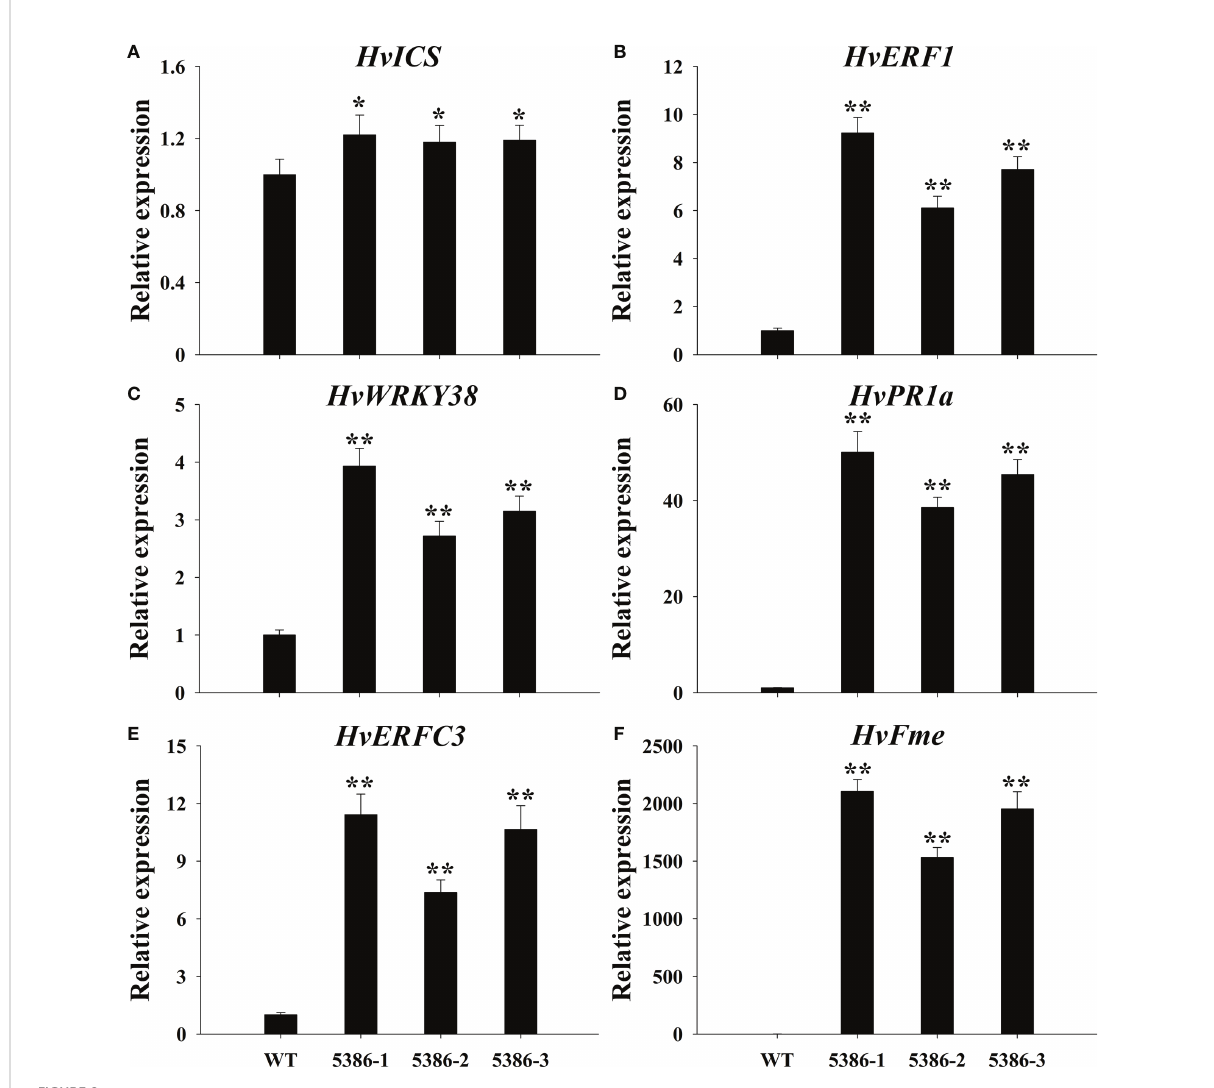
FIGURE 9 Relative expression of disease resistance-related genes in fl ag leaves of WT and LMM 5386 lines. (A) HvICS , (B) HvERF1 , (C) HvWRKY38 , (D) HvPR1a , (E) HvERFC3 , (F) HvFme . Values are means ± SD based on six replicates. Error bars indicate standard deviations. *P < 0.05; **P <